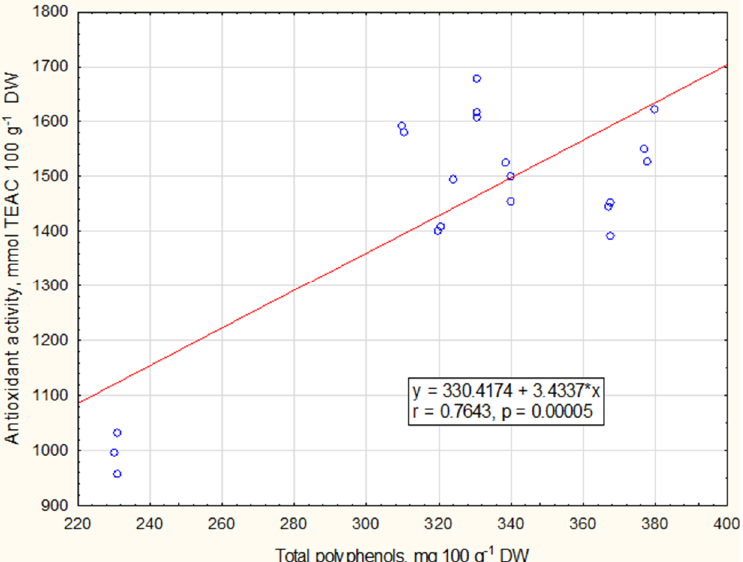
Figure 2. The correlation between total polyphenols and antioxidant activity in fireweed leaves.